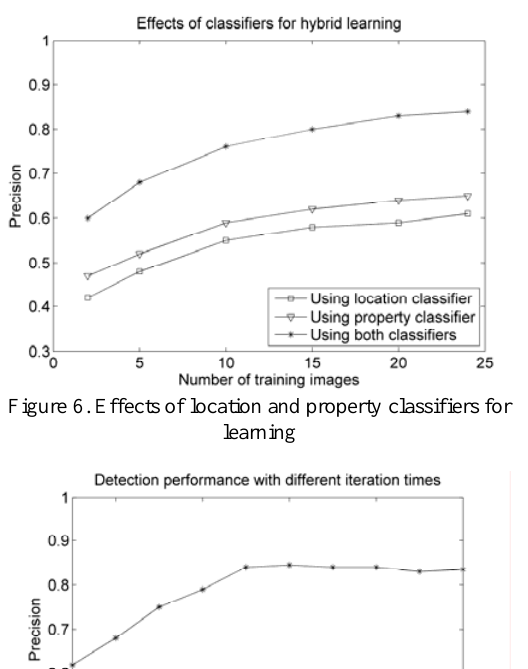
Table 1. Detection precision with different grid factors